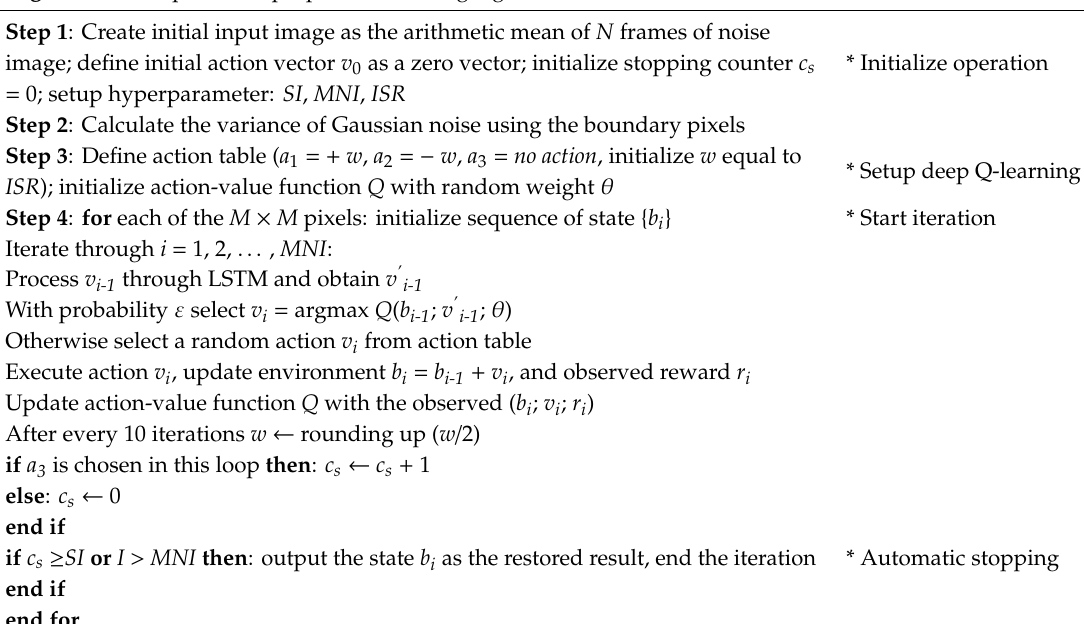
Algorithm 1. Steps for the proposed denoising